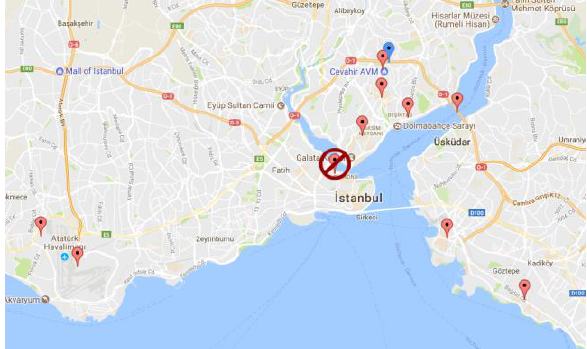
Figure 6. Socially important locations that are discovered by algorithms